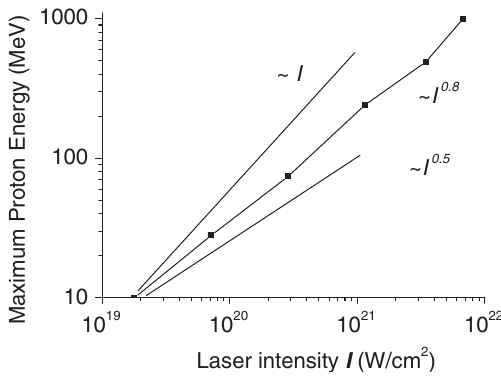
FIG. 4. Maximum proton energy versus laser intensity. The black squares represent results from the 2D-PIC simulations described below; they follow an effective scaling of (cid:3) i (cid:5) I 0 : 8 The upper and lower model limits are shown for